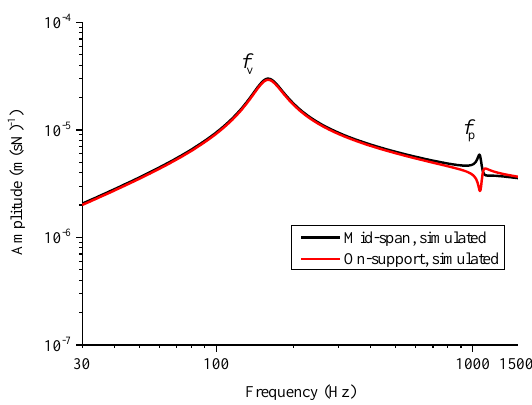
Figure 10. Amplitude of direct vertical rail accelerance.